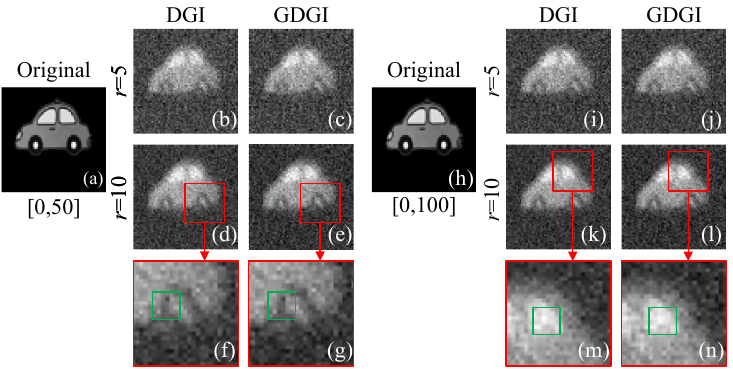
Figure 12. Experimental results of a grayscale object. ( a , h ) are the original object images “car” that are encoded onto DMD 2 , with grayscale ranges of [0, 50] and [0, 100], respectively; ( b – e ) and ( i – l ) are the experimental results recovered by the DGI and GDGI, respectively; ( f – g ) and ( m – n ) are the enlarged detailed images of ( d – e ) and ( k – l ),